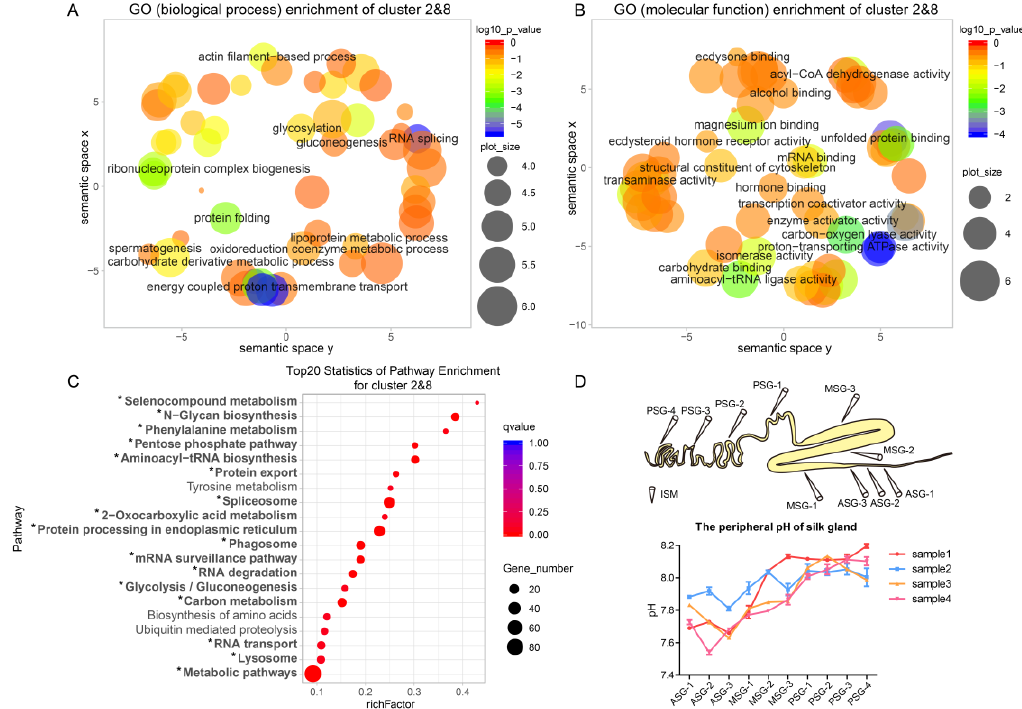
Figure 5. Functional analysis of gradually upregulated genes. ( A , B ) GO scatterplot constructed with REVIGO for gradually upregulated genes related to biological process ( A ) and molecular function ( B ). ( C ) KEGG pathway enrichment analysis of gradually upregulated genes in cluster 2 and cluster 8. “*” (qvalue < 0.05) represents a significantly enriched pathway. ( D ) Detection of the peripheral pH of the silk gland by ion-selective microelectrode (ISM).